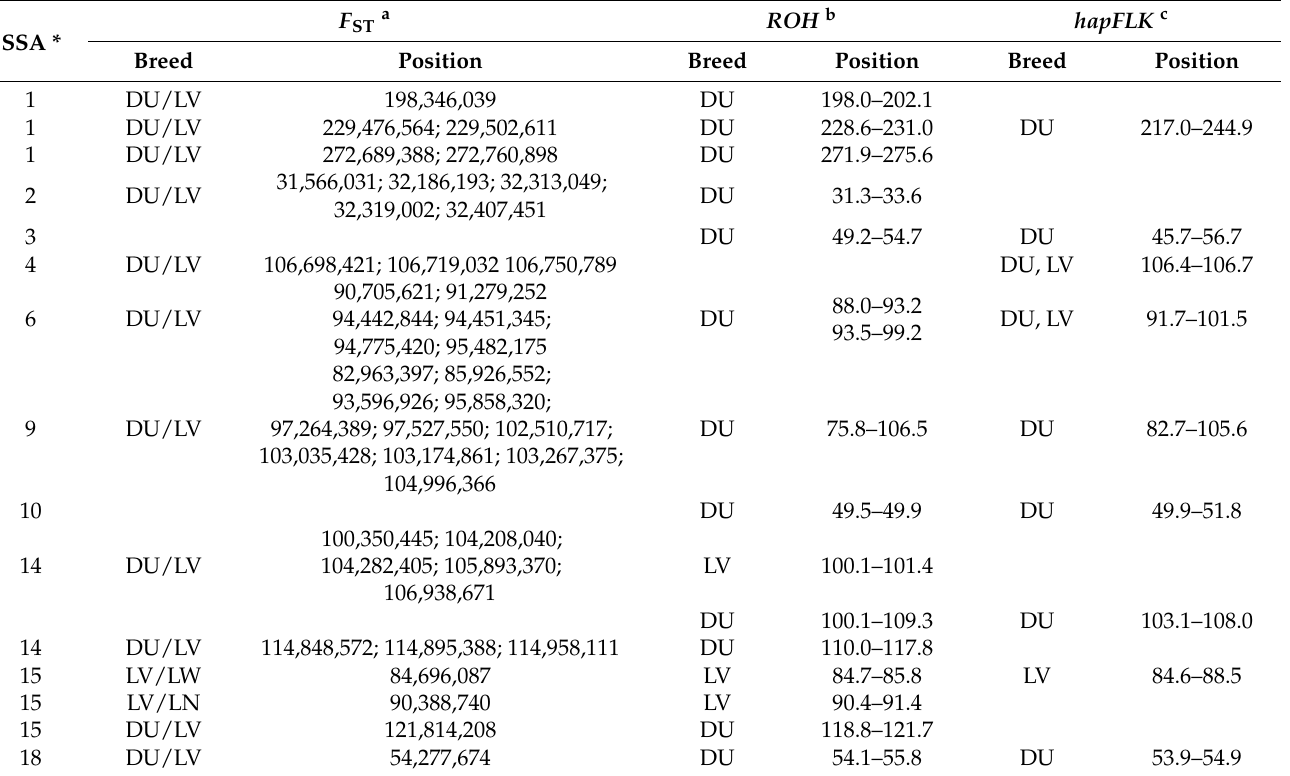
Table 2. Overlapped genomic regions and/or SNPs under putative selection identified by at least two different statistics in the Duroc (DU) and Livni (LV) breeds.